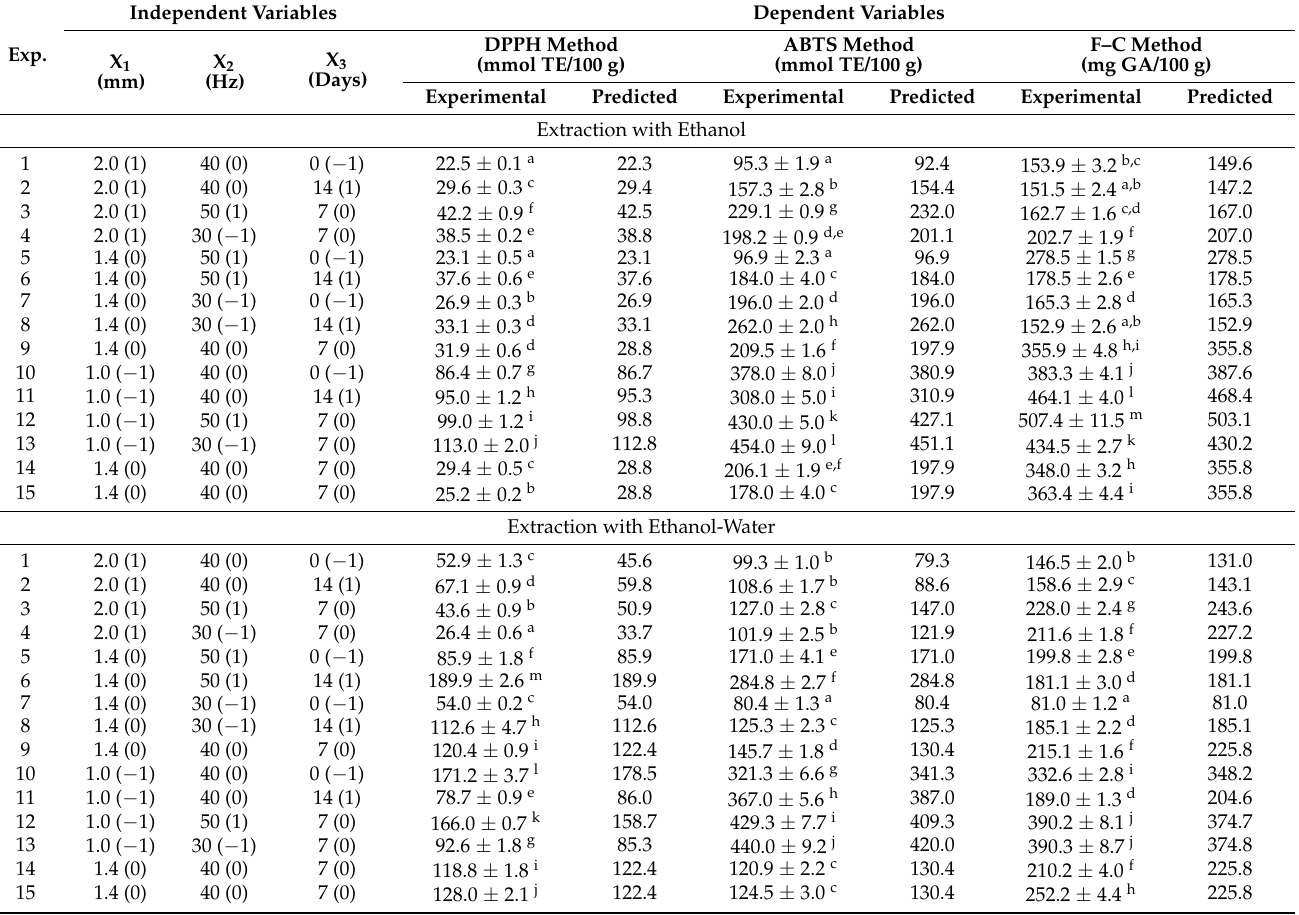
Table 1. Three-level Box–Behnken design with experimental ( x ± SD ) and predicted results for the antioxidant properties of ginger